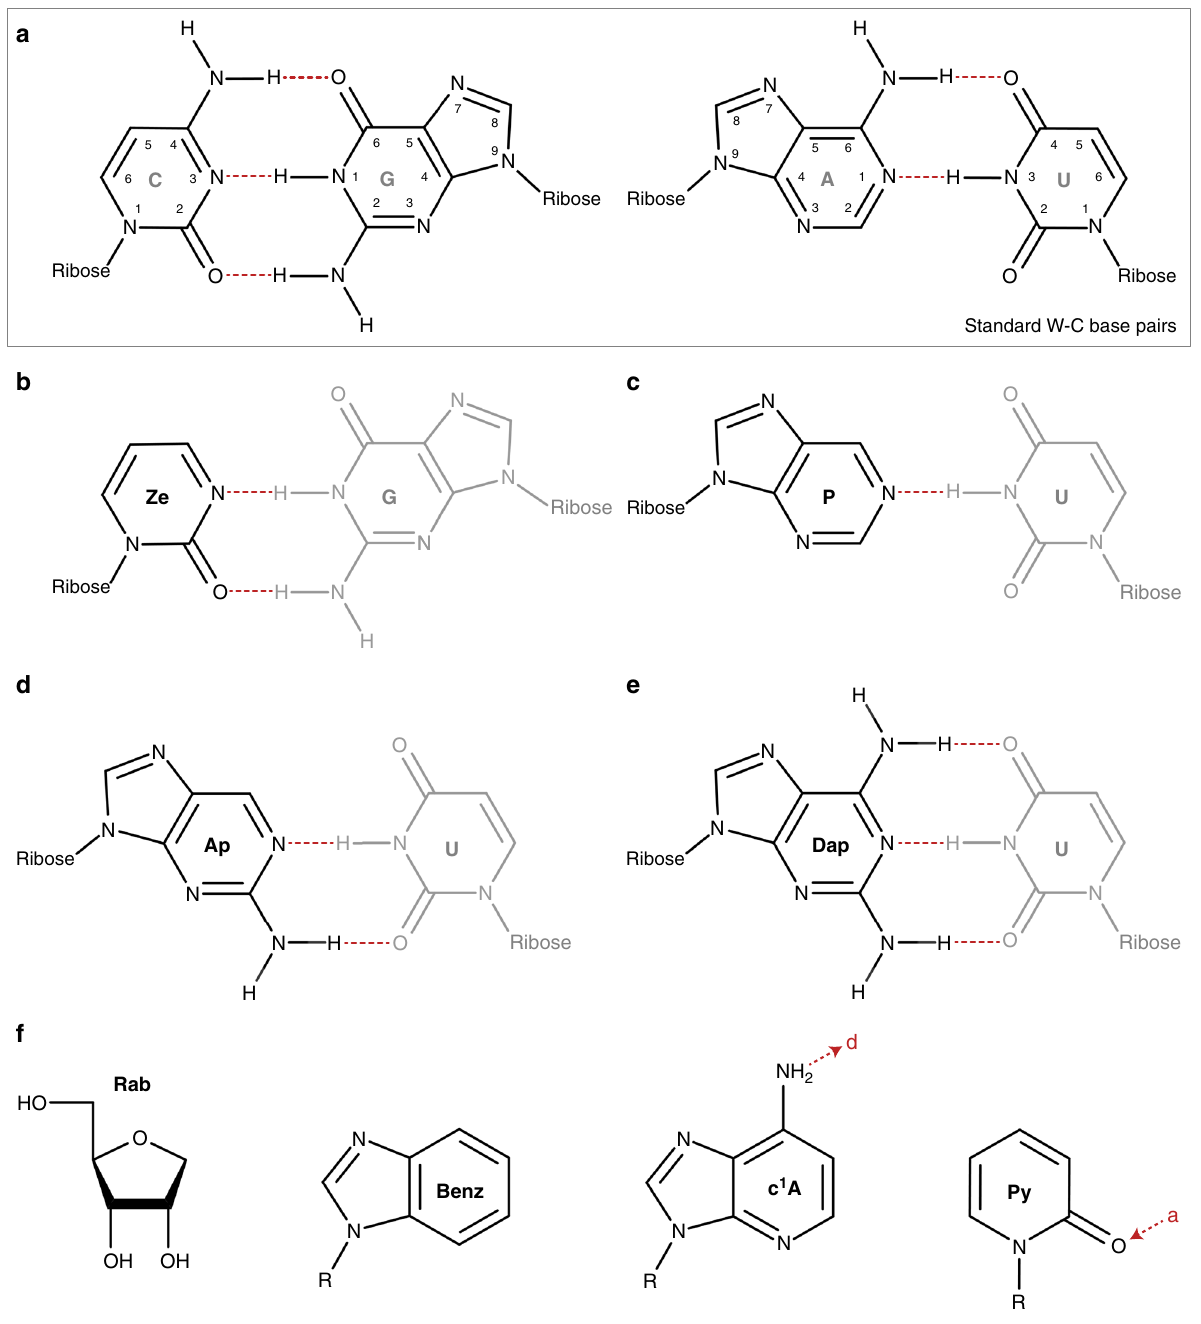
Fig. 1 Interactions between standard and modi fi ed bases. a Standard C – G and A – U base pairs and the H-bonds formed are depicted. b – e Modi fi ed bases employed in this study and their potential binding partners are shown in W – C-like geometry. The modi fi ed and the standard nucleobases are depicted in black and gray, respectively. f Chemical structures of modi fi ed bases that either cannot form H-base pairs or depend on an exocyclic group. H-bonds are depicted in red (Ze zebularine, P purine, Ap 2-aminopurine, Dap 2,6-diaminopurine, Rab ribose abasic, Benz benzimidazol, c 1 A 1-deazaadenosine, Py 2- pridone, d H-bond donor, a H-bond